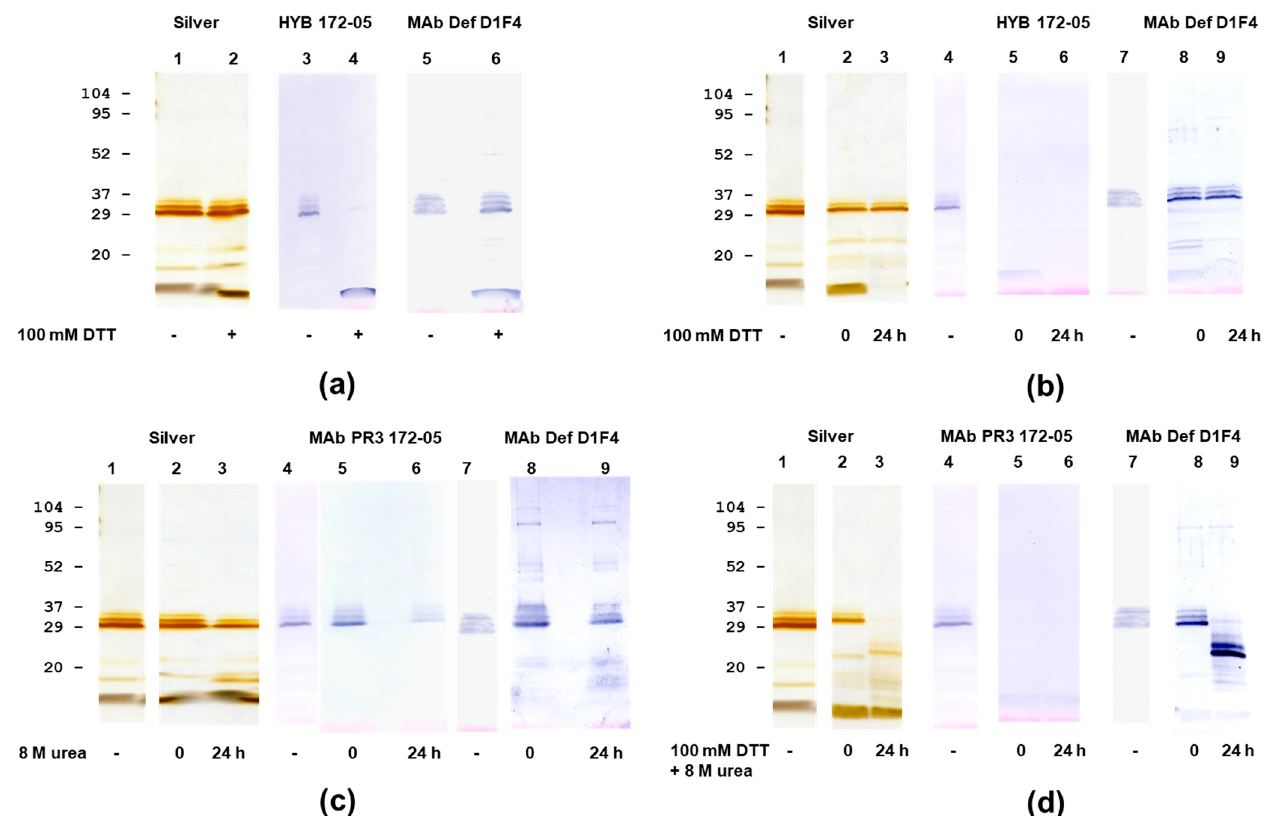
Figure 6. Immunoblotting analysis of PR3 (Wieslab). ( a ). Effect of DTT (100 mM) reduction during sample preparation. ( b ) Effect of long-term high concentration of DTT (100 mM) treatment. ( c ) Effect of long term 8 M urea treatment. ( d ) Effect of long term 8 M urea + 100 mM DTT treatment.